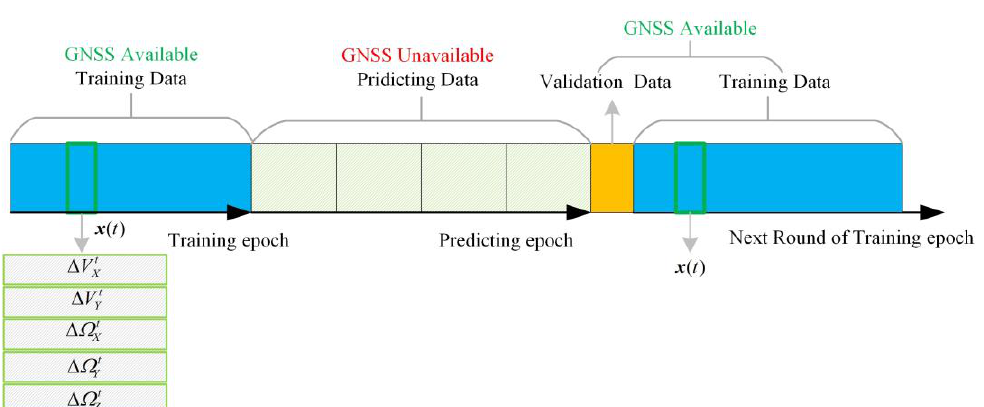
Figure 8. The data structure of the LSTM predicting mode.